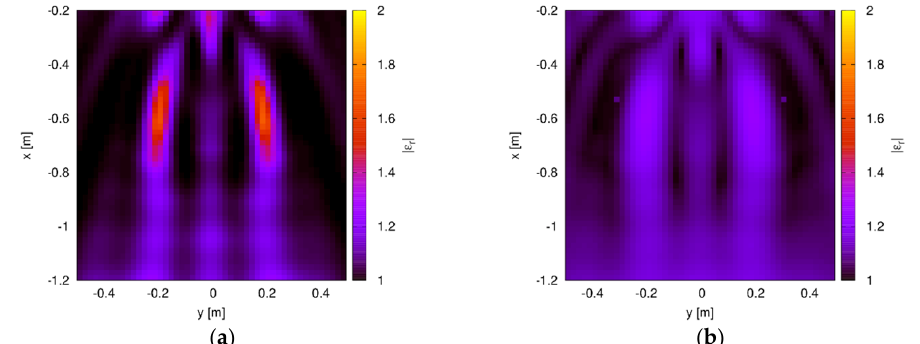
Figure 6. Reconstructed distribution of the relative dielectric permittivity inside the TW investigation domain. Two dielectric cylinders. ( a ) Optimal value of the norm parameter ( 𝑝 opt = 1.3) and ( b ) standard Hilbert-space approach ( 𝑝 = 2 ).